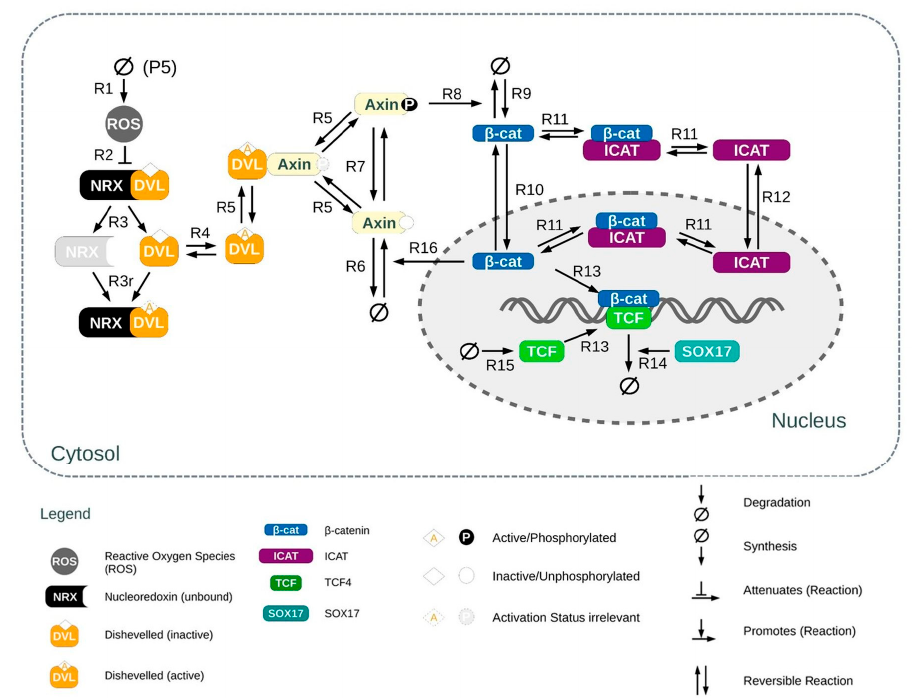
Figure 7. Schematic representation of the implemented model of the Wnt-independent β -catenin pathway. Arrows indicate the state change of the a ff ected molecule, such as synthesis or degradation reactions (R1, R6, R9, R14, R15), complex formation or dissociation (R2, R3, R3r, R5, R11, R13), activation or inactivation (R4, R7), and shuttling (R10, R12). Note that double arrows represent reversible reactions / state changes. Reactions that occur more than once in the figure actually refer to one and the same reaction and have been included to increase readability. This applies in particular for complex formation, where for each molecule a separate arrow points to the final complex, while referring to the one reaction (e.g., R11: β -cat + ICAT ↔ β -cat / ICAT, β -cat ( β -catenin), ICAT (inhibitor of β -catenin and TCF-4)). Arrows (or horizontal lines) that point towards another arrow indicate a promoting (or attenuating) e ff ect of the molecule on the given reaction (R8, R14, R16). For example, SOX17 (SRY-box transcription factor 17) promotes the degradation of the β -catenin / TCF (transcription factor) complex (R14). Phosphorylated AXIN is labeled by a white P on a black circle while active, self-aggregated Dishevelled (DVL) complexes are indicated by an orange A. Please note that for some reactions the molecule’s state of activity is not relevant, e.g., the phosphorylation state of AXIN has no impact on its binding to activated Dvl (Dvl [A]). Please see the legend for a detailed description of the graphical elements used in the